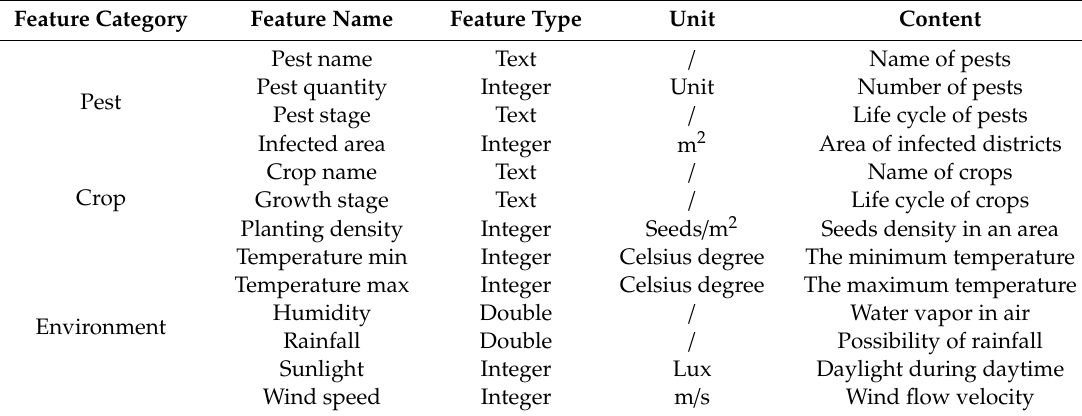
Table 1. Agricultural cases defined by the feature vector